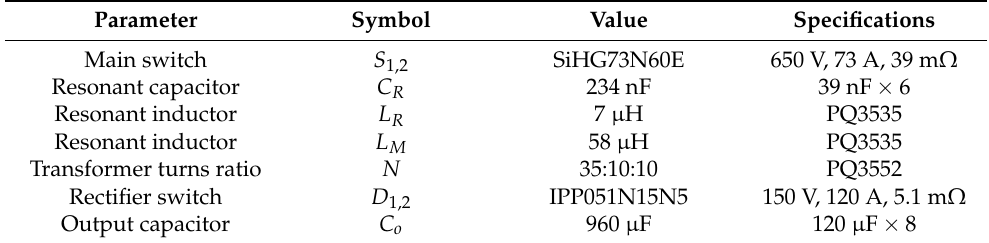
Table 4. Main components and electrical ratings used in the experimental